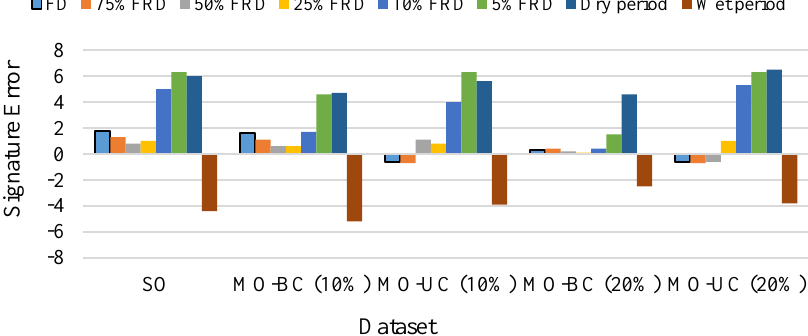
Figure 16. R QP errors based on observations and simulations of five datasets using two main calibration approaches (SO & 4 algorithms parameterization of MO-SB).